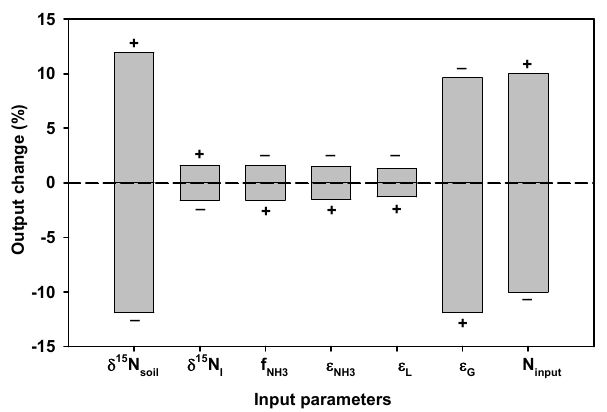
Fig. 6. Sensitivity of denitrification to different input parameters. “+” and “-” represent a 10% increase and 10% decrease in the input parameter,